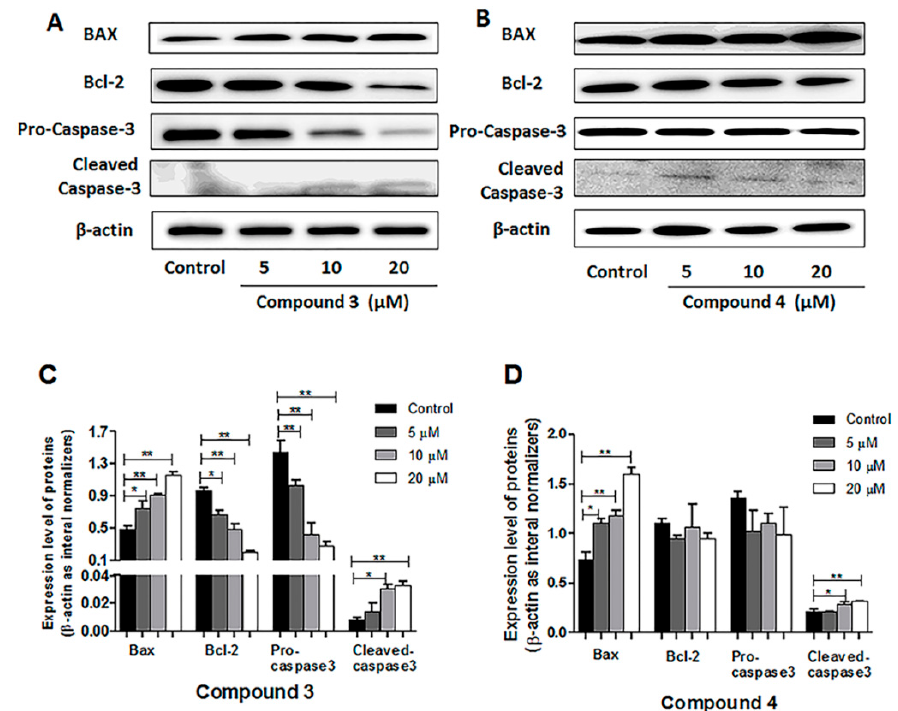
Figure 8. Western blots were performed to analyze relative protein expression levels involved in the cell apoptosis including Bax, Bcl-2, pro-caspase-3, and cleaved caspase-3( A and B ). β -actin was used as a control. HeLa cells were treated with different concentrations (5, 10, 20 μ M) of compound 3 or 4 for 24 h. The obvious change could be seen in the histogram in a concentration-dependent manner ( C and D ), * p < 0.05, ** p < 0.01, compared with the control group.